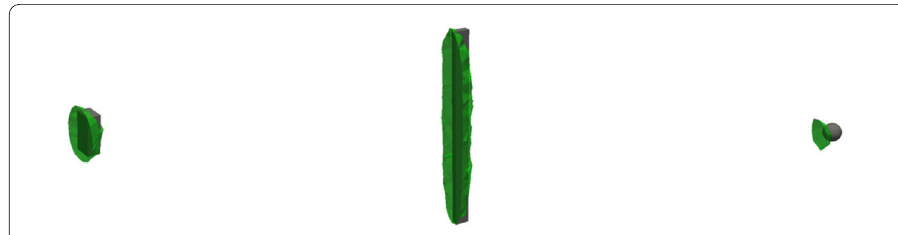
Figure 19 Reconstruction of the three defects for λ = 0.3 Left: perspective of the box-shaped defect. Center: perspective of the groove-shaped defect. Right: perspective of the spherical defect. The reconstructed defects do not depend highly on the choice of the value for